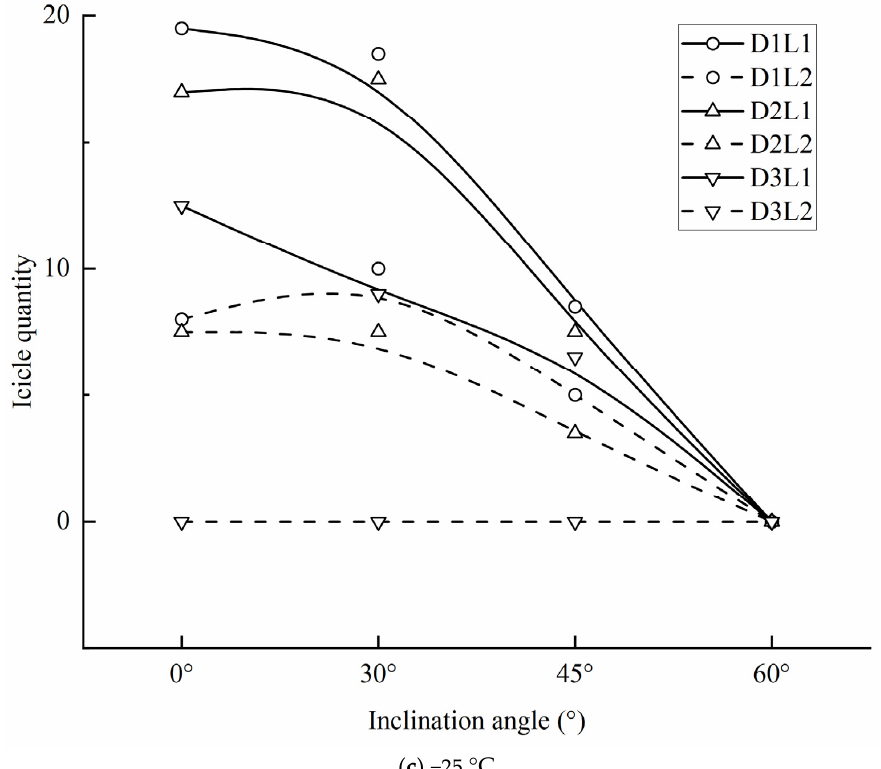
Figure 11. ( a – c ) In fl uence of cable inclination angle on the number of icicles (per meter).